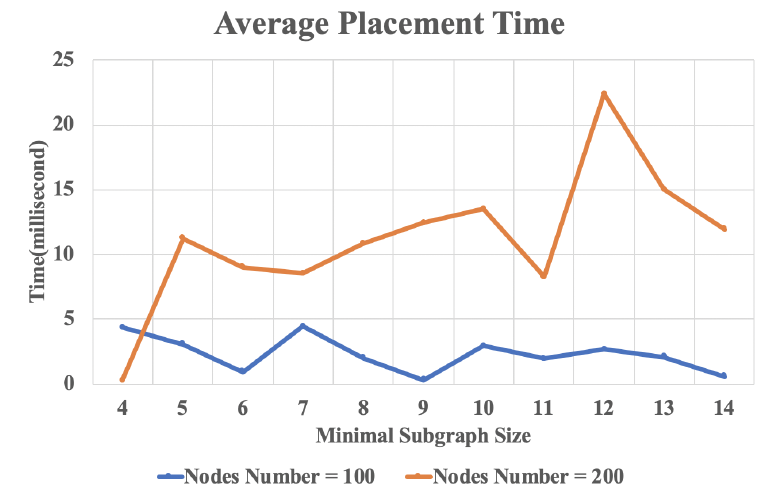
Figure 10. The result of average placement time with different subgraph